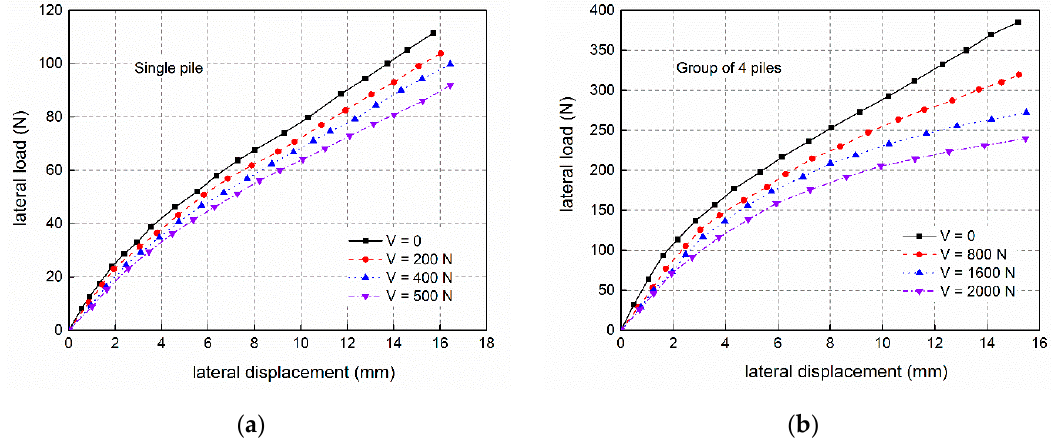
Figure 7. Lateral load vs. displacement results from model pile tests (reproduced from Jain et al. [40]): ( a ) single pile, ( b ) pile group.